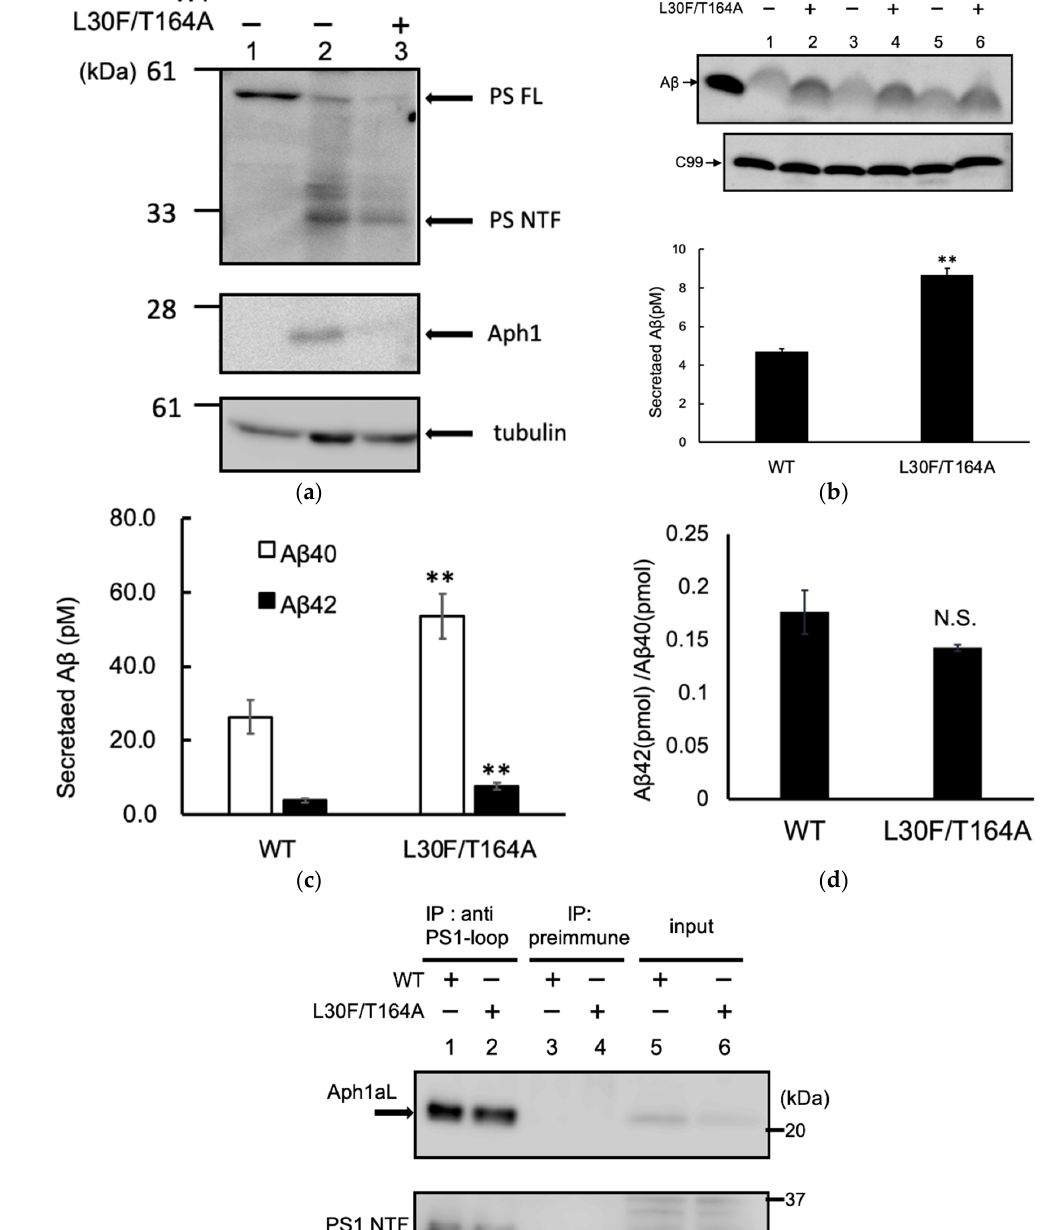
Figure 6. Production of A β by Aph1 mutants in mouse embryonic fibroblasts. Using the retroviral system, Aph1 knockout cells were transfected with Aph1 WT or Aph1 L30F/T164A. Cells were harvested; extracts were then analyzed by immunoblotting with the indicated antibodies ( a ). Endoproteolysis of PS1 was detected by the production of mature fragment PS1 NTF. Secretion of A β peptides ( b , c ). After transfection, the media was recovered, and the total secreted A β was analyzed by immunoblotting ( b ). The amount of secreted A β was quantified from three independent assays and is shown with standard deviations ( b ). The amounts of A β species ( c ) and the ratio of A β 42 with A β 40 ( d ) were quantified by ELISA ( n = 11; data represent the mean ± SD). Asterisks on each bar indicate p < 0.01 (**) with respect to the Aph1 WT by the Student’s t test ( b – d ). The γ -secretase complex was purified from cellular extracts using an antibody against the PS1-loop region (G1L3) or rabbit pre-immune serum, as indicated ( e